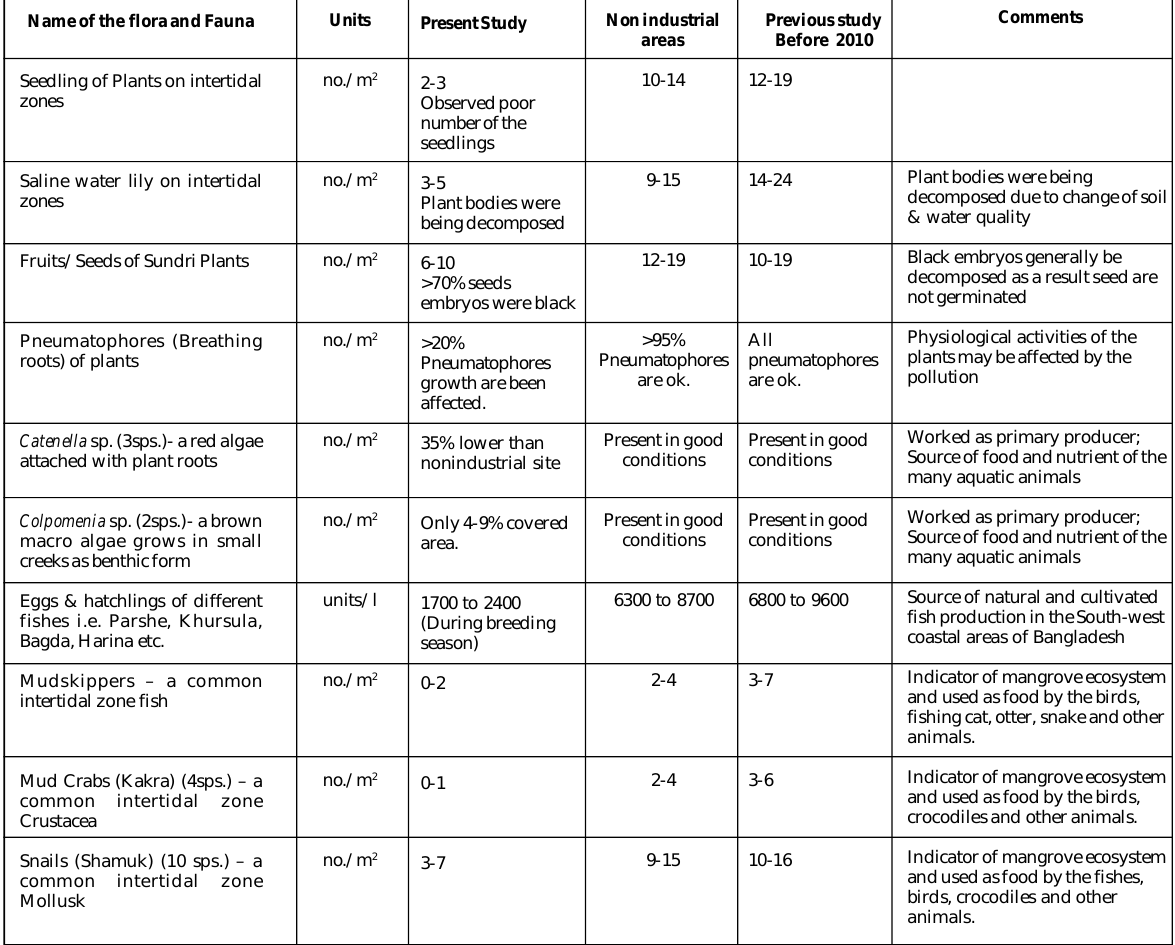
Table 4: Floral and Faunal status of the study areas and other areas of the Sundarbans Name of the flora and Fauna Seedling of Plants on intertidal